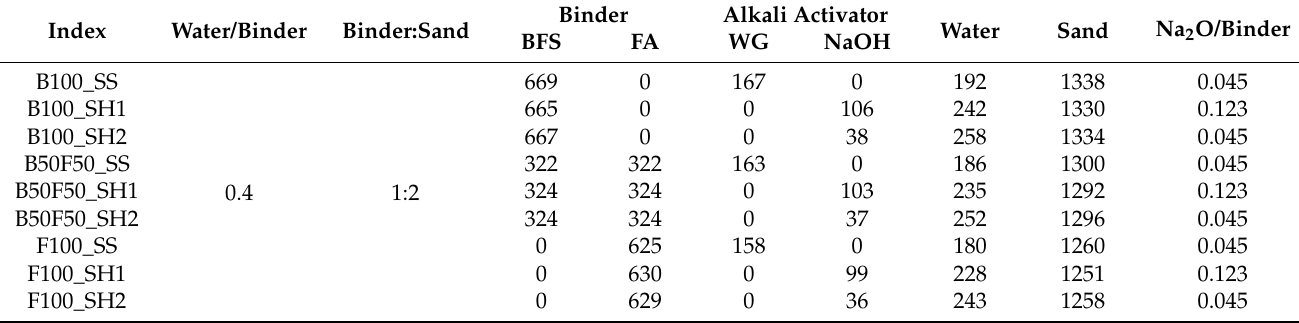
Table 2. Preparation of Mortar Specimens (g/L).